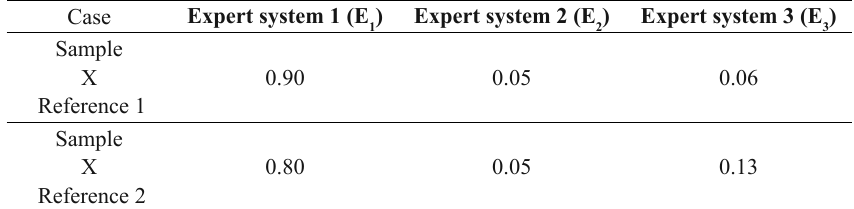
Summary of results of expert